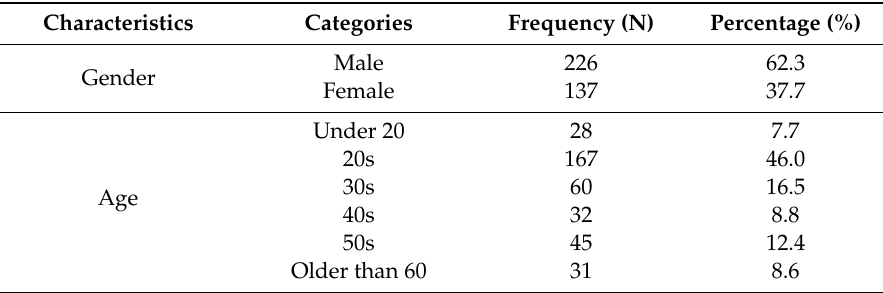
Table 2. Profile of respondents.